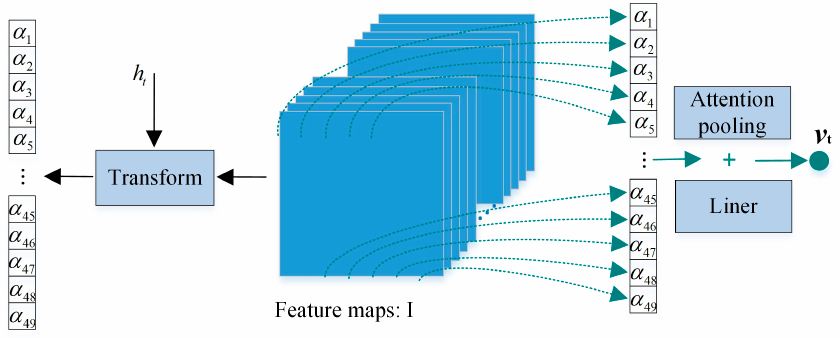
Figure 3. The architecture of attention1. This structure can learn a set of weights, which represent the degree of attention to different areas of the image.